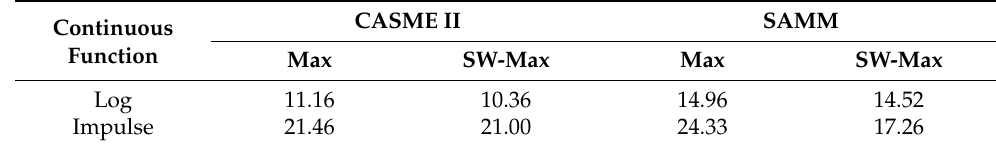
Table 3. MAE of Apex spotting using various continuous label